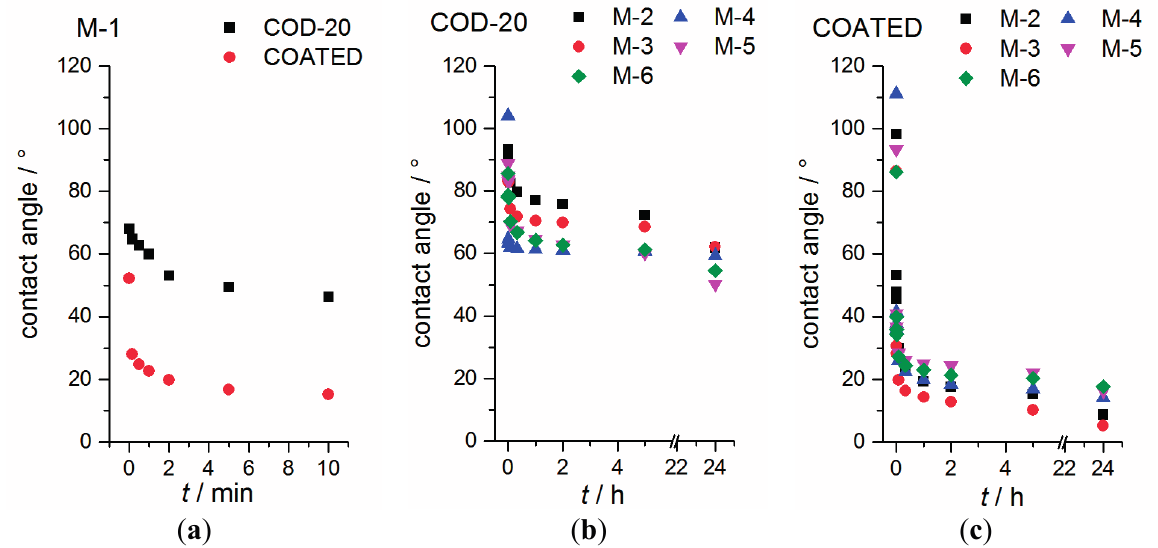
Figure 8. Time-dependent contact angles between separator and mixtures. ( a ) Contact angles between mixture M-1 and both separators are depicted within 10 min; ( b ) Contact angles between mixture M- n ( n = 2–6) and separator COD-20 are shown within 24 h; and ( c ) Contact angles between mixture M- n ( n = 2–6) and separator COATED are compared within 24 h.